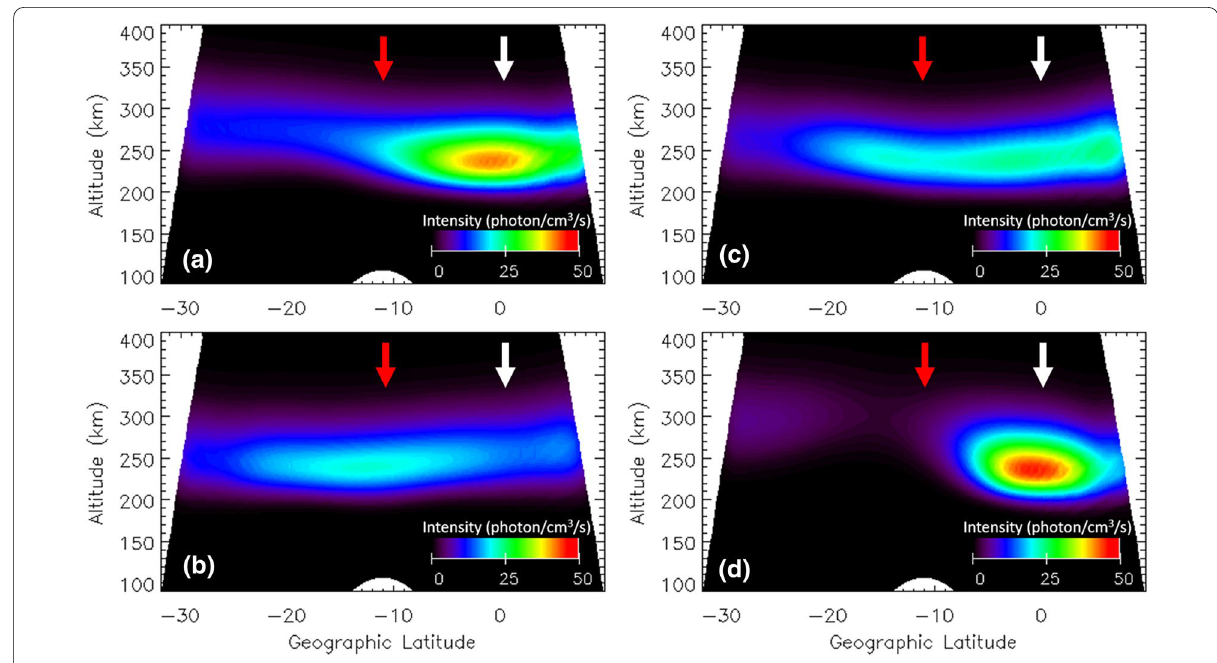
Fig. 5 The same as in Fig. 4, but along the 80° W